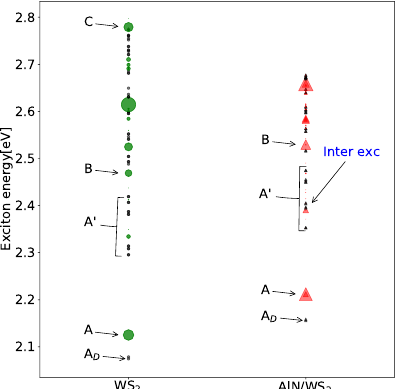
Figure 5. Schematic representation of the exciton level in the WS 2 layer and AlN / WS 2 bilayer. Here, we report the excitons at zero momentum—those responsible for the optical absorption. The size of the dots is proportional to the dipole of the different excitons. Dark states are represented by black dots. In the AlN / WS 2 case, we also report the position of the first inter-layer exciton. The nomenclature of excitonic states A D (dark spin forbidden), A (bright), B (bright), C (bright) is consistent with literature on